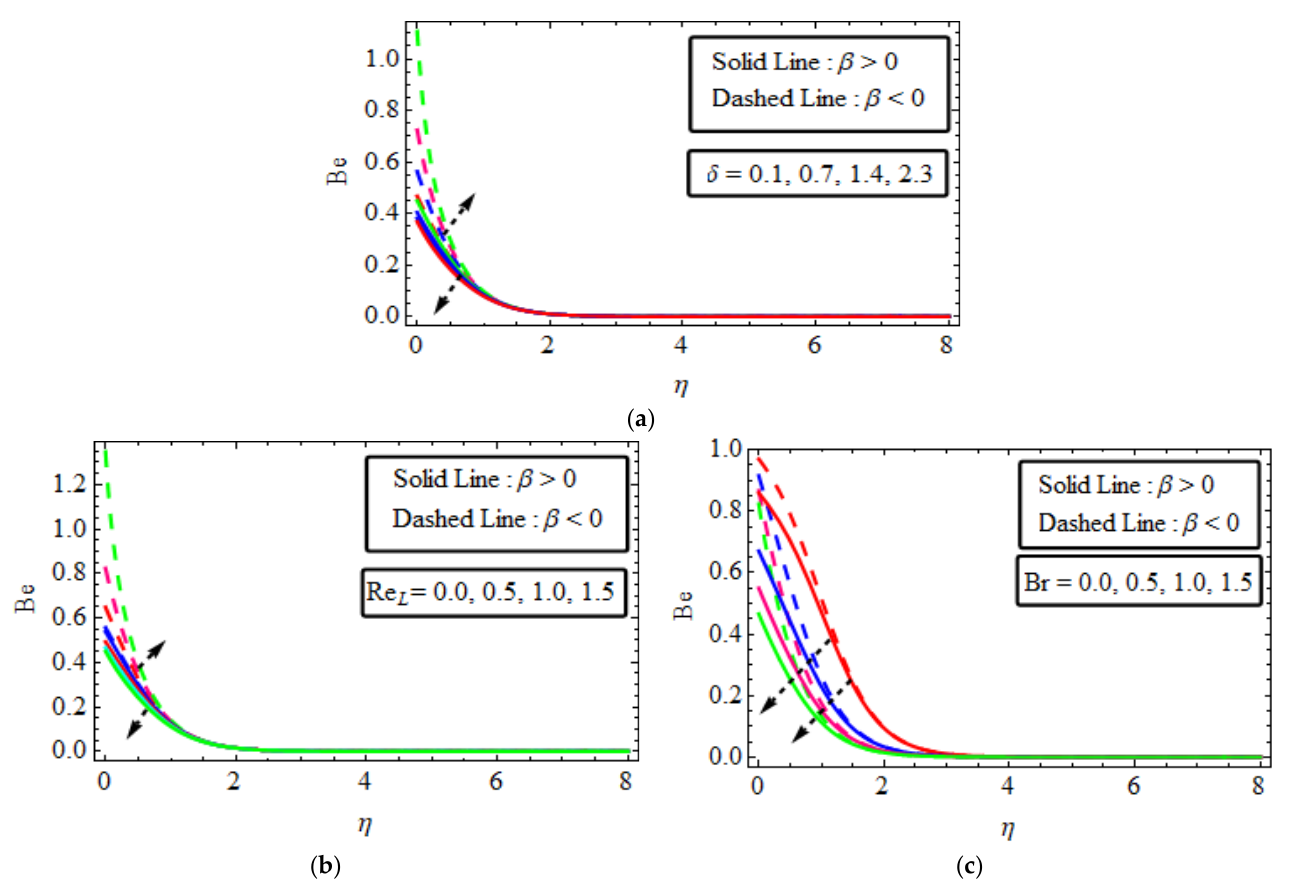
Figure 8. ( a – c ) The impact of Be numerous variables ( a )  ( b ) Re